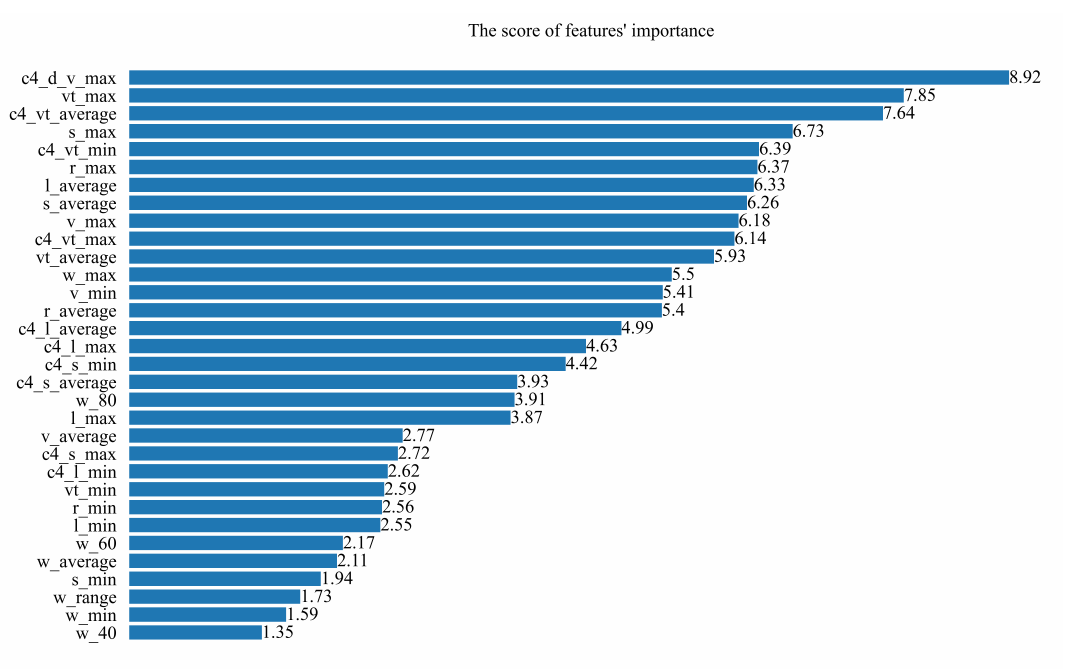
Figure 4. The flow of the TDA-RF model training and optimization. (The ‘parameters’ obtained from the GridSearch were used as input for the next GridSearch or to obtain the optimal model; Model-1 was the optimal model with 32 features, and Model-2 was optimal with 20 features).